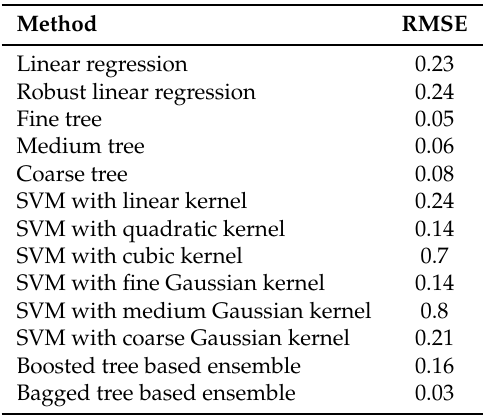
Table 1. Comparison of regression models using 5-fold